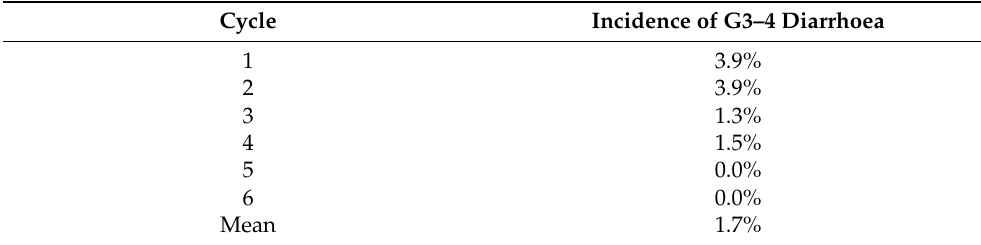
Table 1. Incidence of grade 3–4 diarrhoea out of the total population evaluated.